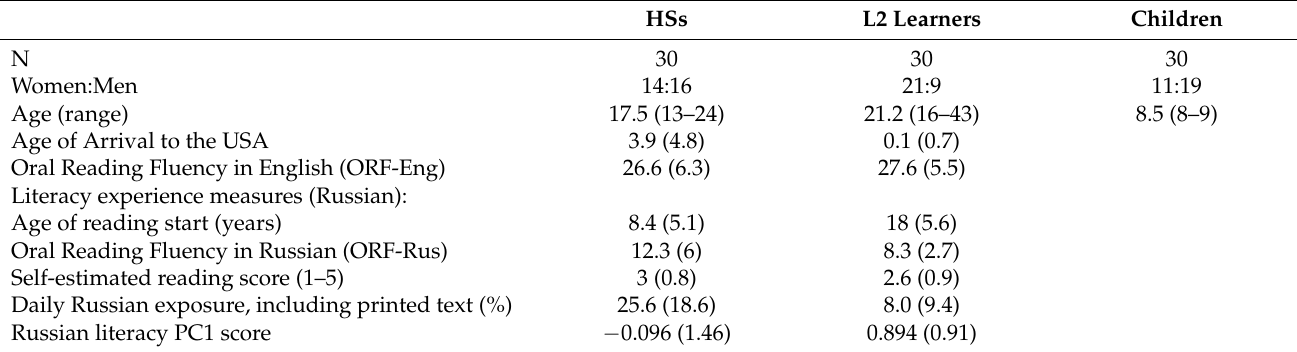
Table 1. Participant characteristics and reading assessment